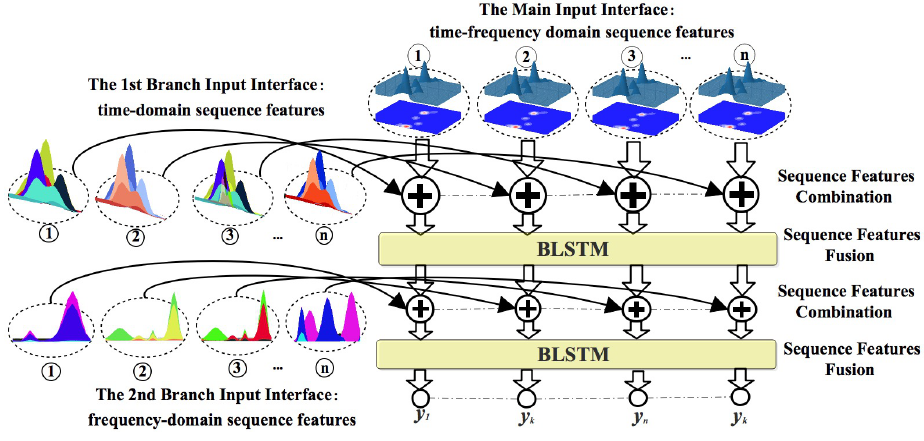
Figure 4. The proposed multi-input